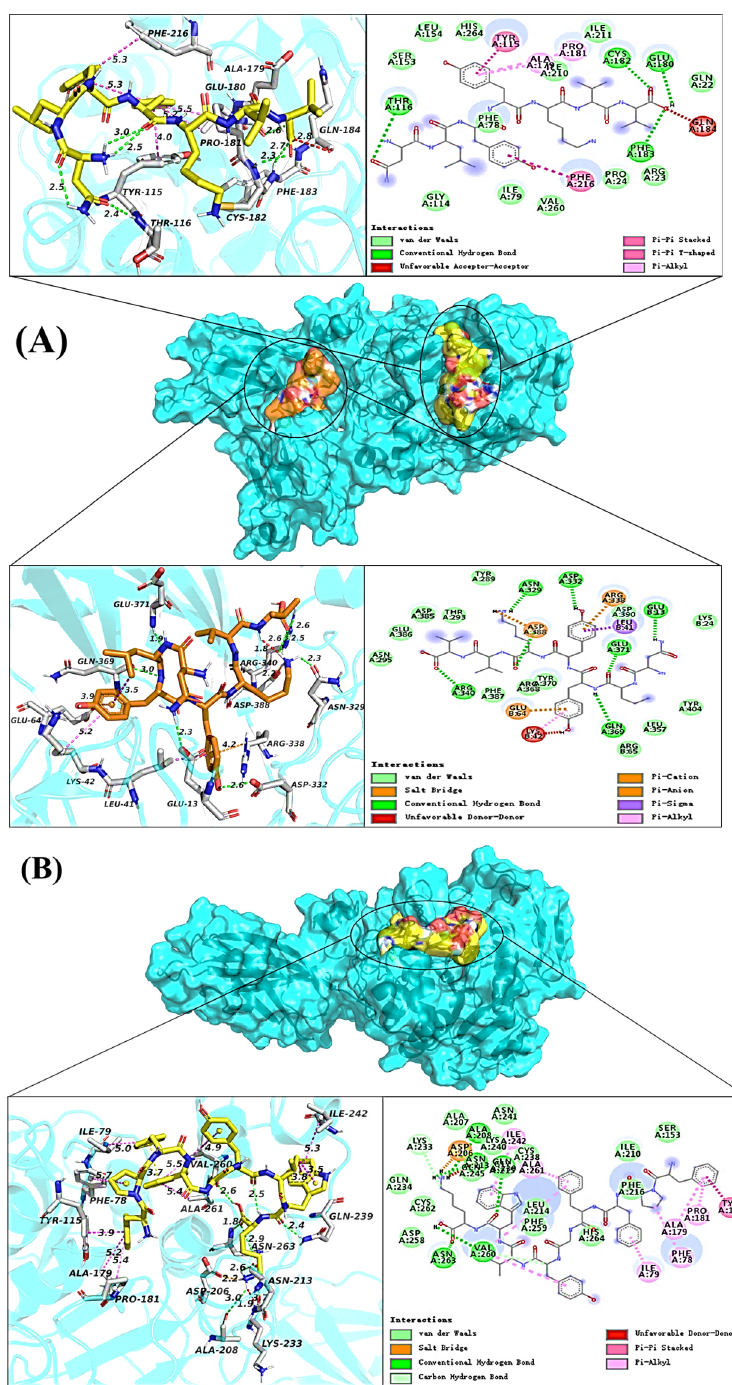
Figure 3. Molecular docking analysis of pancreatic lipase with peptides ( A ) NV-7; ( B ) FK-9.